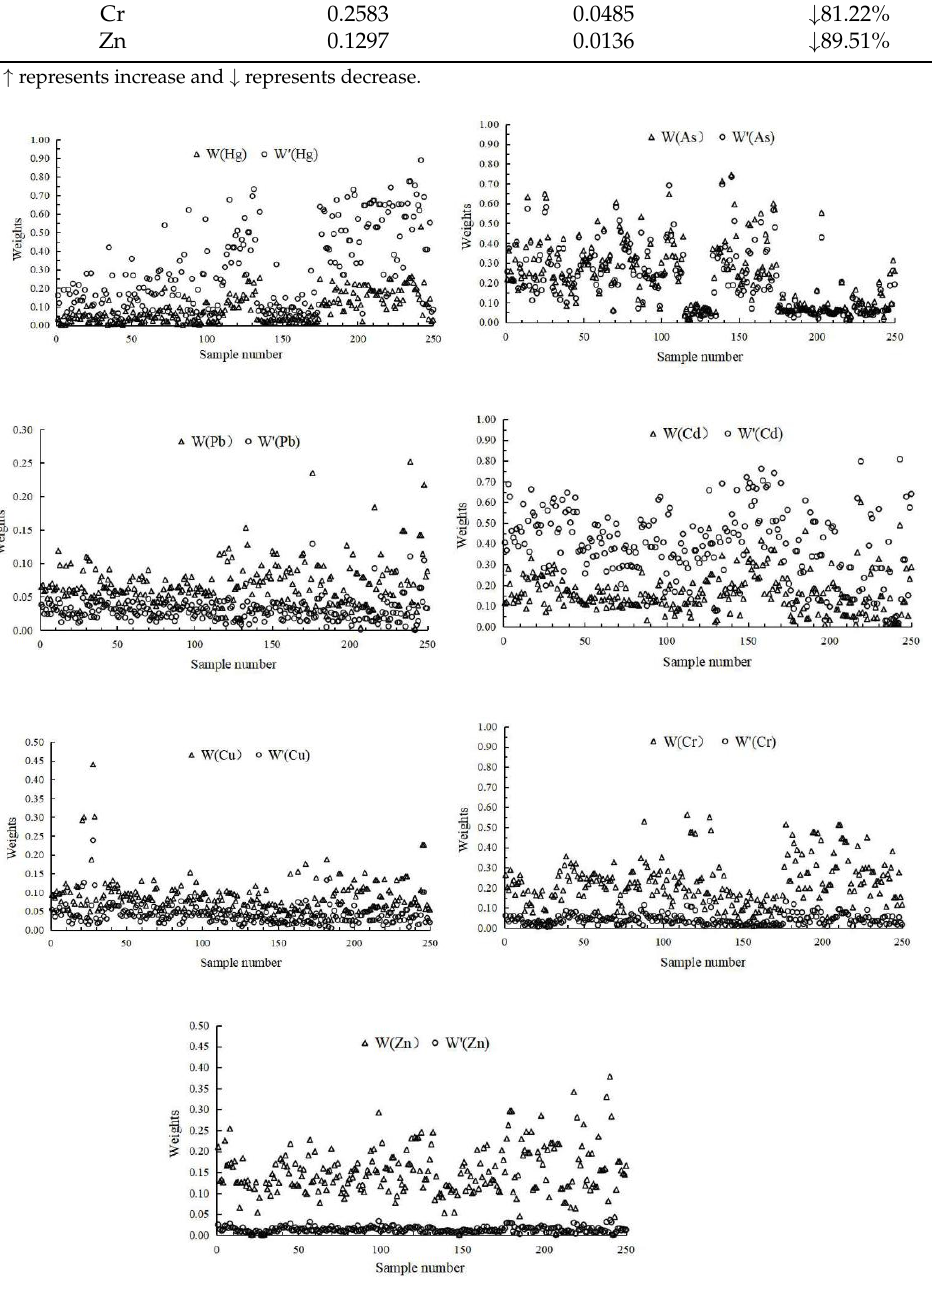
Figure 2. Comparison of the weights of potential toxic elements at different sampling points before (W) and after (W (cid:48) ) correction by introducing the toxic response